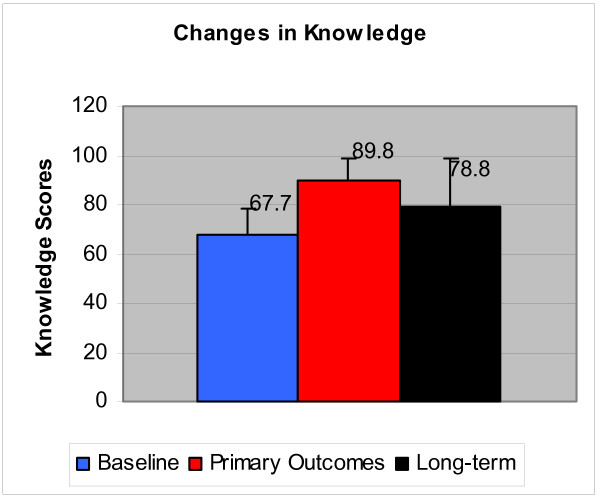
Changes in Knowledge, Confidence, and Communication. • Baseline to Long-term Outcomes P-value < 0.001 (determined by Wilcoxon). • Primary Outcome to Long-term Outcomes P-value < 0.001 (determined by Wilcoxon).